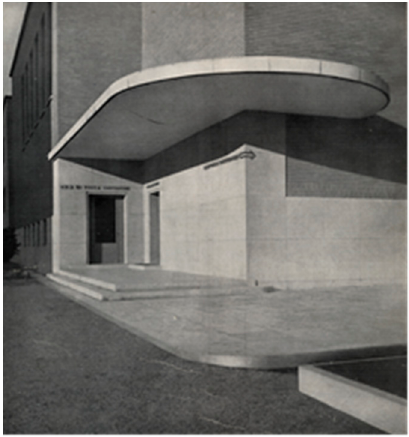
Figure 37. The side entrance to the classrooms. Photo from (Papini 1936, p. 5).